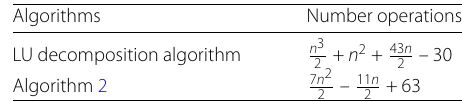
Table 2 Comparison of the total number of operations for the inverse of A Algorithms Number operations LU decomposition